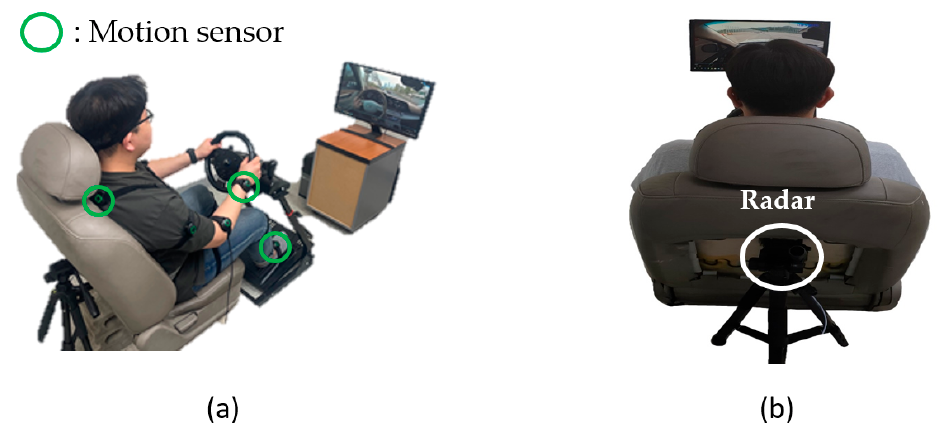
Figure 7. Respiratory signal measurement environment. ( a ) Experimental setup and location of wearable motion sensors attachment, ( b ) location of FMCW radar.